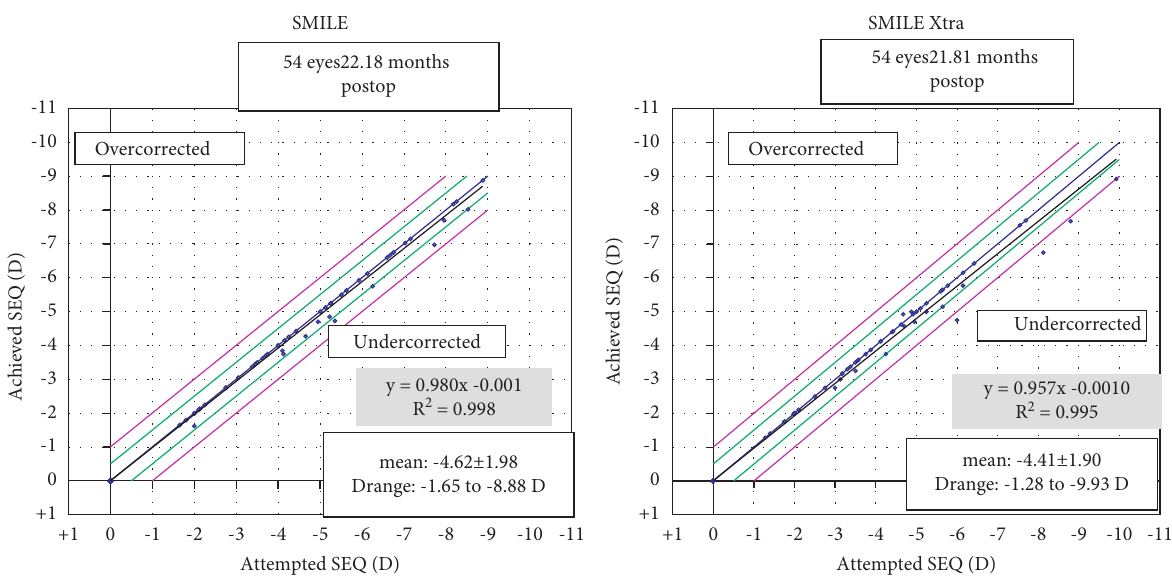
Figure 4: Spherical equivalent refraction